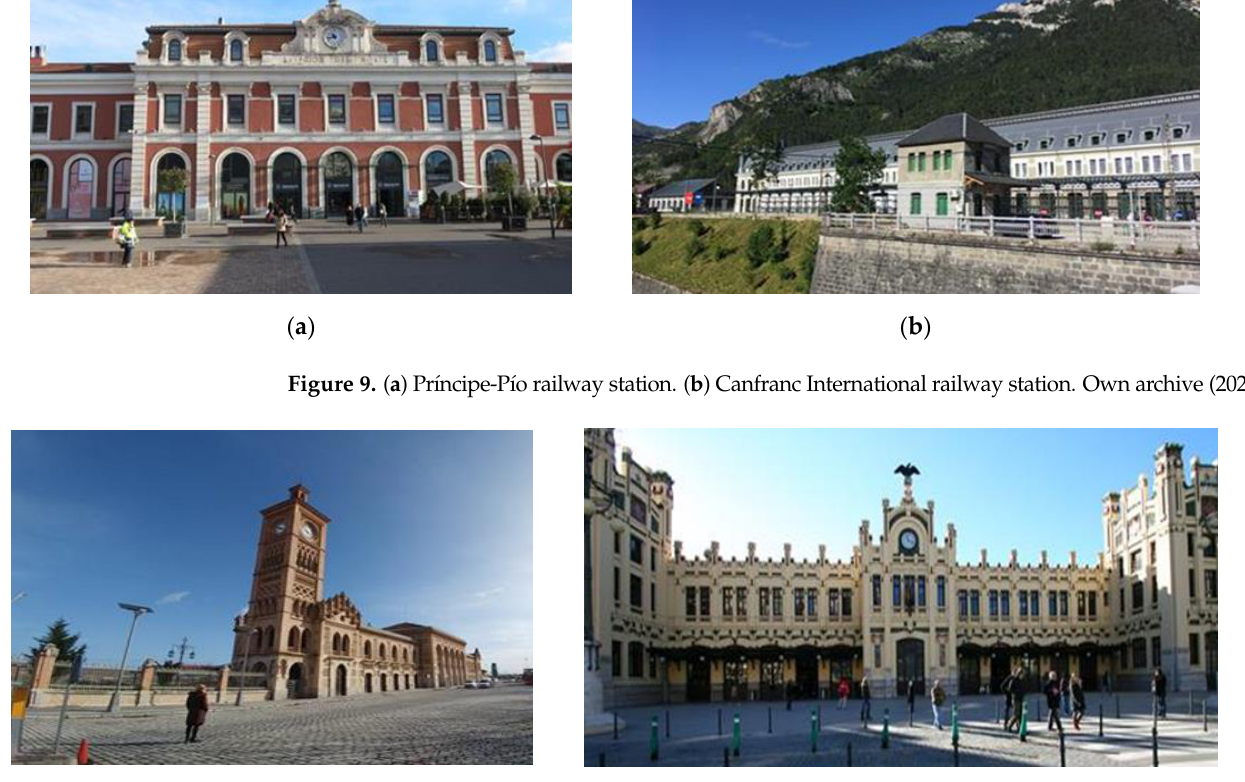
Figure 10. ( a ) Toledo railway station. ( b ) Valencia-Nord railway station. Own archive